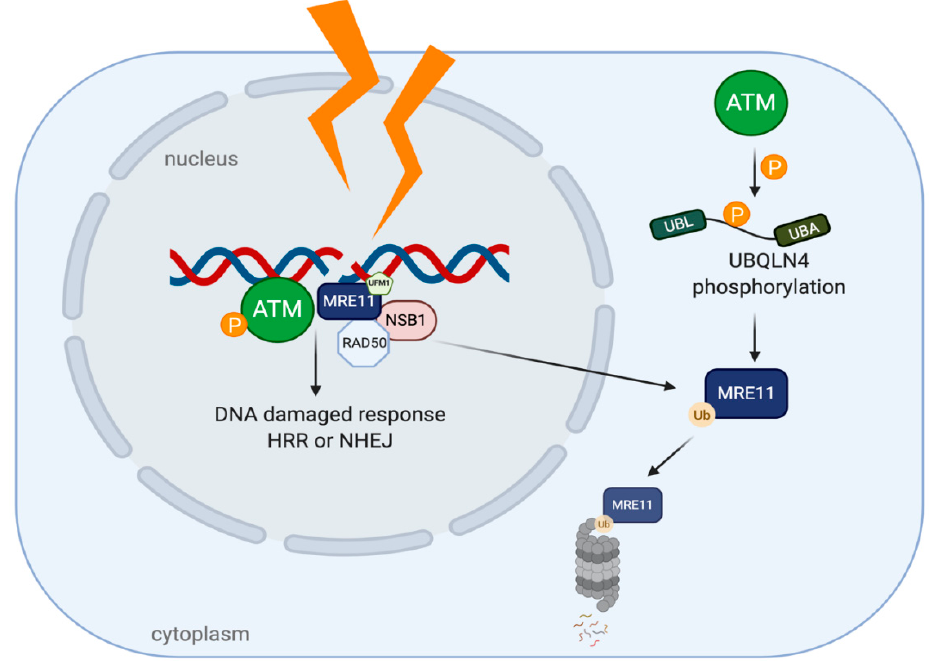
Figure 6. UBQLN4 and DNA repair networking in cancer. After DNA damages, Ataxia Telangiectasia Mutated (ATM) is auto-phosphorylated and MRN complexes are recruited to the damaged sites, leading to DDR. The phosphorylation of UBQLN4 by ATM can later induce MRE11 ubiquitination and degradation by UPS.